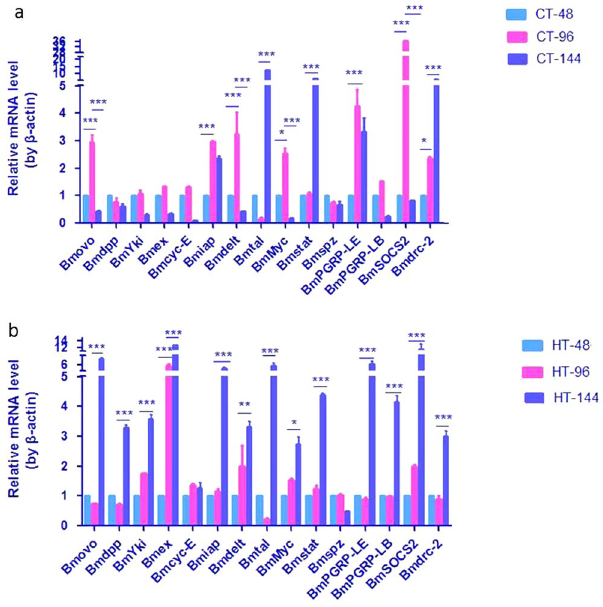
Figure 8. Relative expression levels of genes in the midgut of the fifth instar larvae in all samples. ( a ) Control samples; ( b ) THTT samples; CT/HT-N, samples mentioned in Table